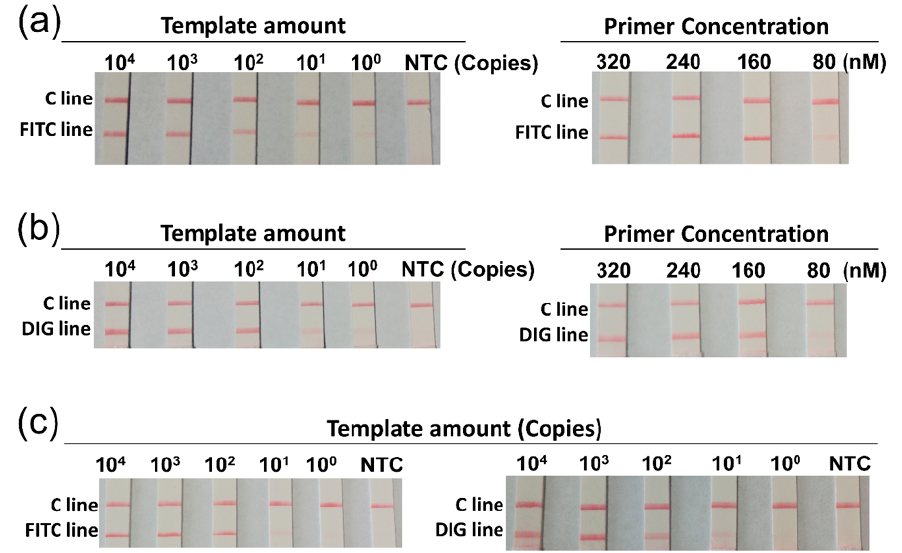
Figure 2. Optimization of the duplex RPA reaction. The concentration range of the primer/probe set in the single detection assay was determined for V. vulnificus ( a ) or V. cholerae ( b ). Different template amounts were tested in the single detection assays with the primer/probe concentrations set as recommended by the manufacturer of the reagent (the left panels of a and b ). The final concentrations were: [forward primer] = 320 nM, [reverse primer] = 320 nM, and [probe] = 96 nM. The template amount was indicated on top of each strip. Using 10 2 copies of the templates (the right panels of a and b ), the primer/probe concentrations were decreased proportionally (forward primer:reverse primer:probe =1:1:0.3) to determine the concentration range. Concentration of each primer was indicated on top of the strip run amplicons of the corresponding reaction. Then the sensitivity of the duplex RPA reaction was confirmed ( c ). Mixed templates (double template of V. vulnificus and V. cholerae ) of different amounts were tested and separately visualized for V. vulnificus (left panel of c ) and V. cholerae (right panel of c ). Final concentrations of the primers and probes in the duplex RPA reaction: [each primer] = 160 nM, and [each probe] = 48 nM. The NTC strips were the no-template controls. The 2-segment strips were used to visualize amplicons with corresponding labels. The images represent results from three independent